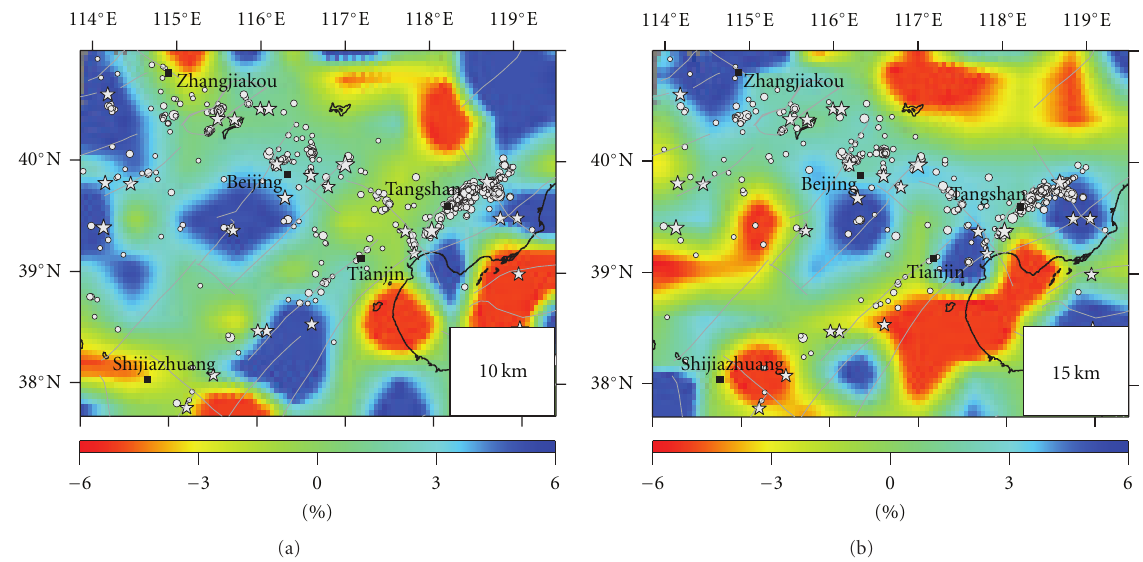
Figure 9: (a) and (b) show the map view of P wave velocity perturbations (in %) and distribution of relocated earthquake hypocenters at 10 km and 15km, respectively. The white circles denote small earthquakes within 5km o ff the di ff erent layer depth. The white stars show historic earthquake hypocenters ( M ≥ 6.0). Red and blue colors denote slow- and fast-velocity anomalies, respectively. The velocity perturbation scale (in %) is shown at the